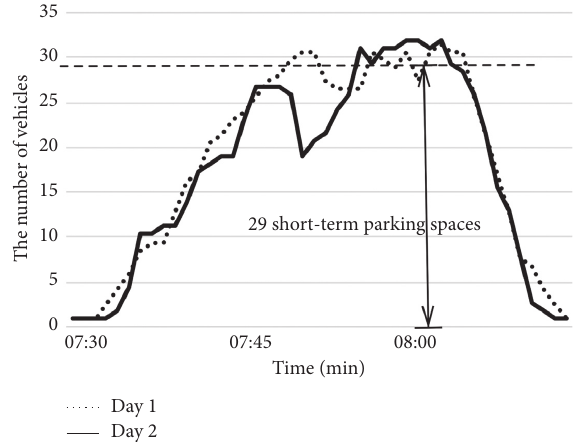
Figure 7: The cumulative number of vehicles with dwell time less than 179seconds.